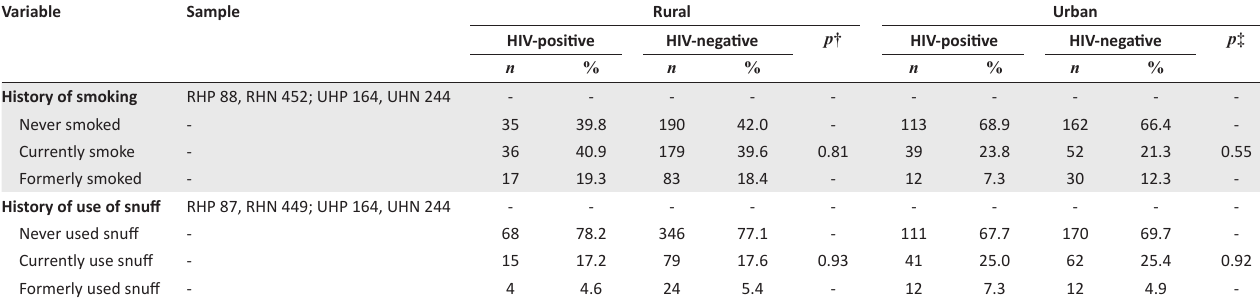
TABLE 1: History of smoking and use of snuff.